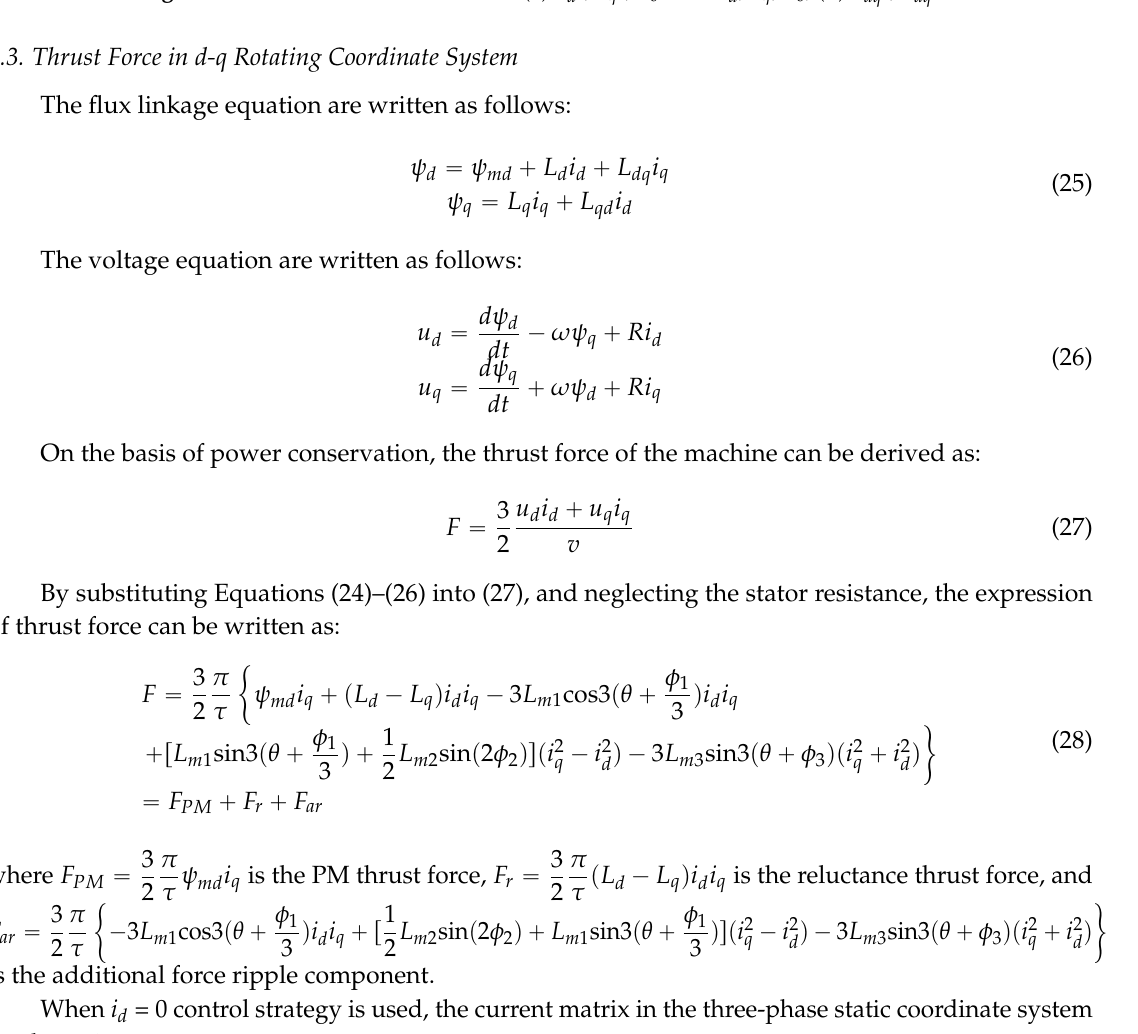
Figure 12. Waveforms of inductances. ( a ) L d ´, L q ´, L 0 ´ and L d , L q , L 0 ; ( b ) L dq ´, L dq .